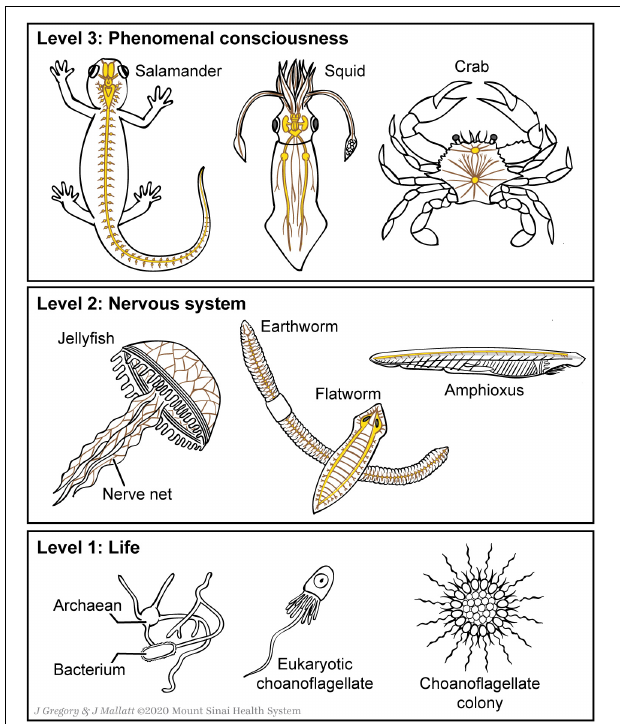
FIGURE 2 | Organisms at the three emergent levels in the evolution of consciousness. Below, the colony of one-celled choanoflagellates shows how multicellular animals may have originated. Figure © Mount Sinai School of